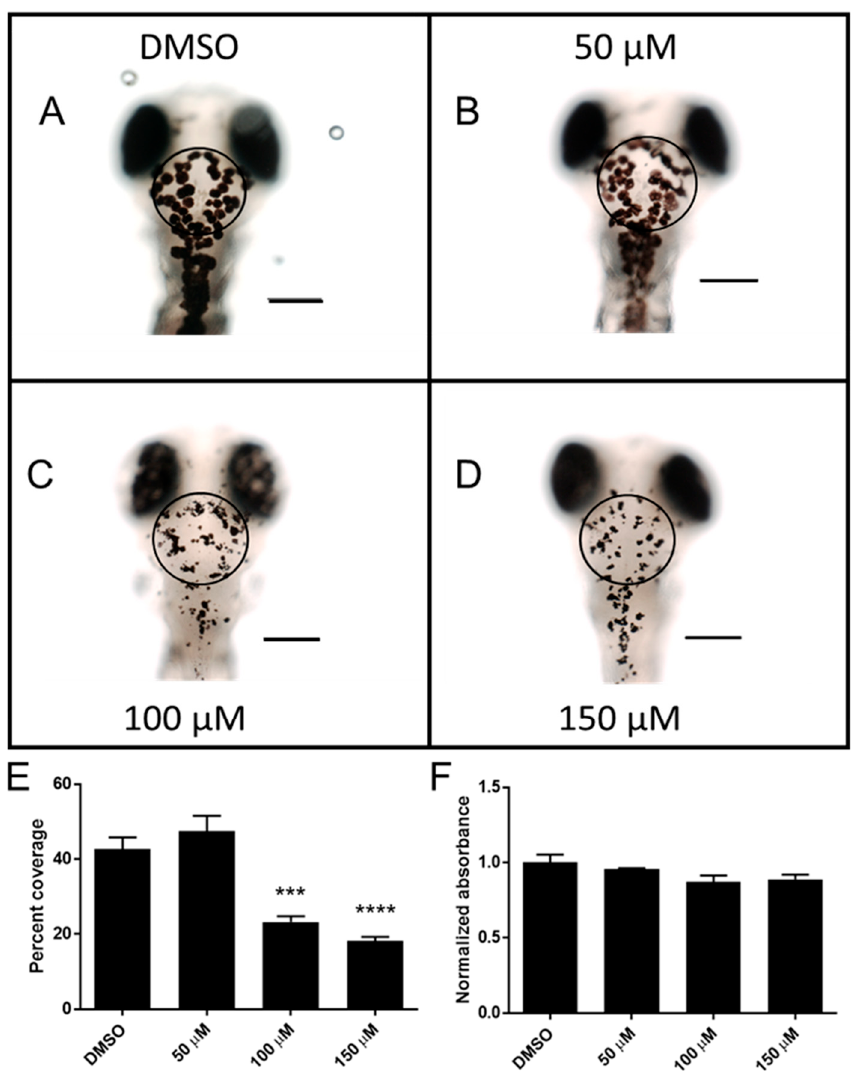
Figure 3. Phenotypic changes due to catechol treatment. In total, 72 hpf larvae were exposed to increasing concentrations of catechol for 48 h under dark conditions prior to fixation. Representative images of each treatment are shown in panels ( A – D ) (( A )—DMSO, ( B )—50 µ M, ( C )—100 µ M, ( D )—150 µ M). The areas used to calculate percent coverage are shown (circles), scale bars—0.2 mm. Percent coverage of melanocyte compared to total area was calculated for 10–14 embryos and is shown in panel ( E ). Melanin quantification was also performed on similarly treated, unfixed embryos (panel ( F )). *** p < 0.001, **** p < 0.0001 compared to DMSO, one-way ANOVA, Bonferroni’s post hoc test.